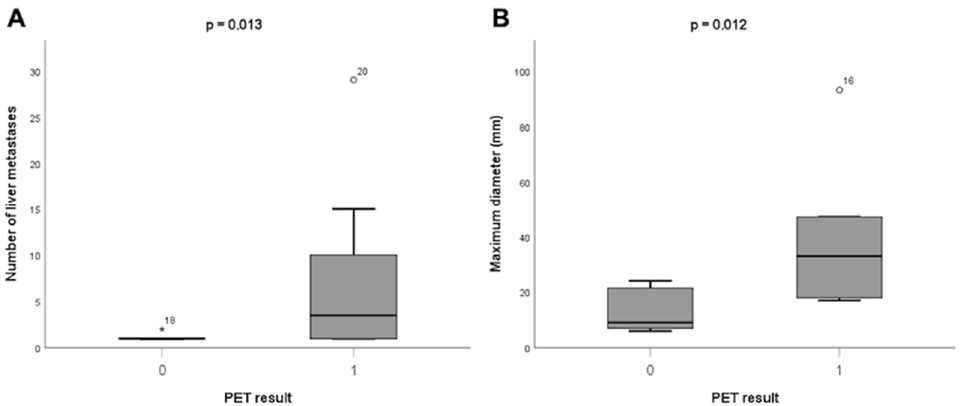
Figure 3. Boxplots for liver metastases characteristics at reference standard and PSMA-PET result: number of liver metastases ( A ) and maximum diameter ( B ). Notes: 0 = negative PET for liver metastases; 1 = positive PET for liver metastases; * = high extreme value, score is more than 3 IQR above quartile